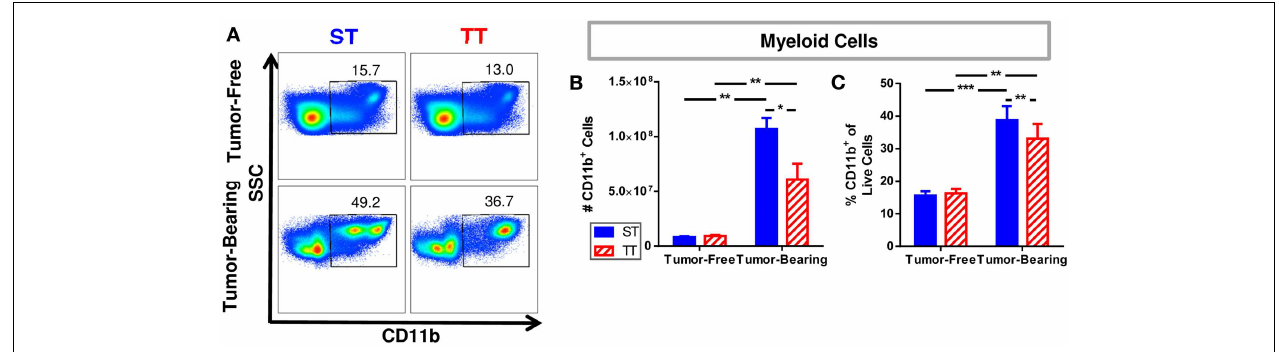
of cells are shown above their respective gate. (B) The absolute number of CD11b + cells calculated from the total number of splenocytes counted in each individual mouse. (C) The percentage of CD11b + cells of the total population of live cells as determined by DAPI staining. Data presented as mean ± SEM; n = 5/group; Student’s t -test; * p < 0.05, ** p < 0.01, *** p <